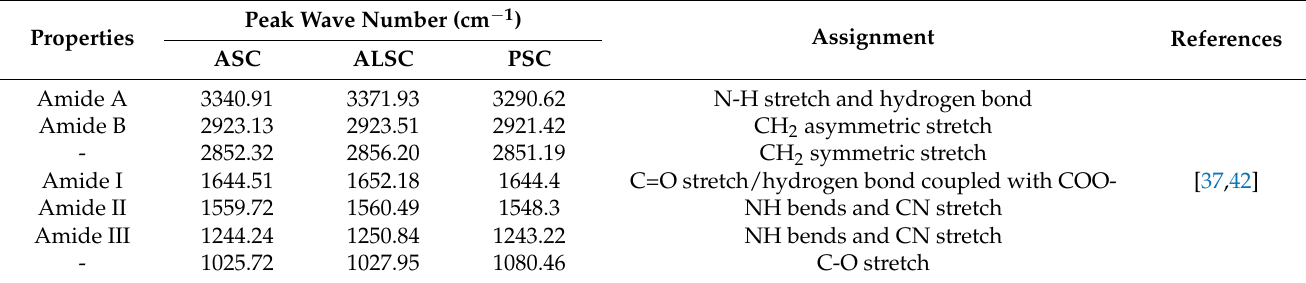
Table 3. FTIR peak locations and assignment for ASC, ALSC, and PSC.